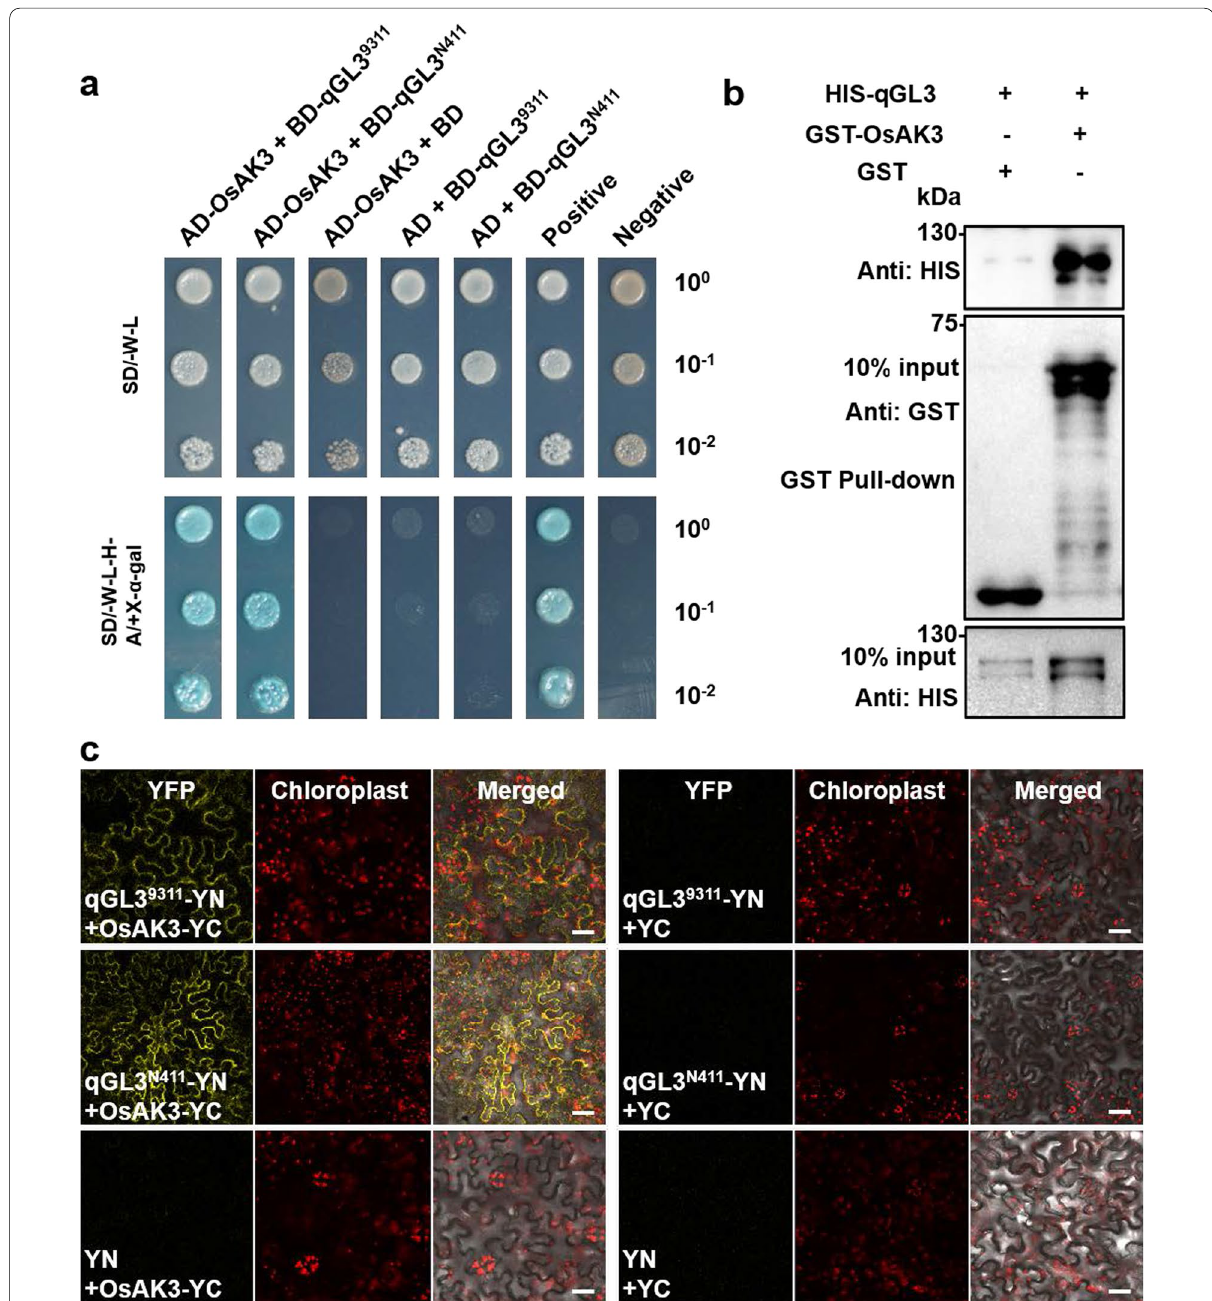
Fig. 1 OsAK3 physically interacts with qGL3. a Interaction between OsAK3 and qGL3 in Y2H analysis. b Interaction between OsAK3 and qGL3 in GST pull-down assay. Immunoblots were probed with anti-GST and anti-His respectively. c BiFC analysis of the interaction between OsAK3 and qGL3 (scale bars, 50